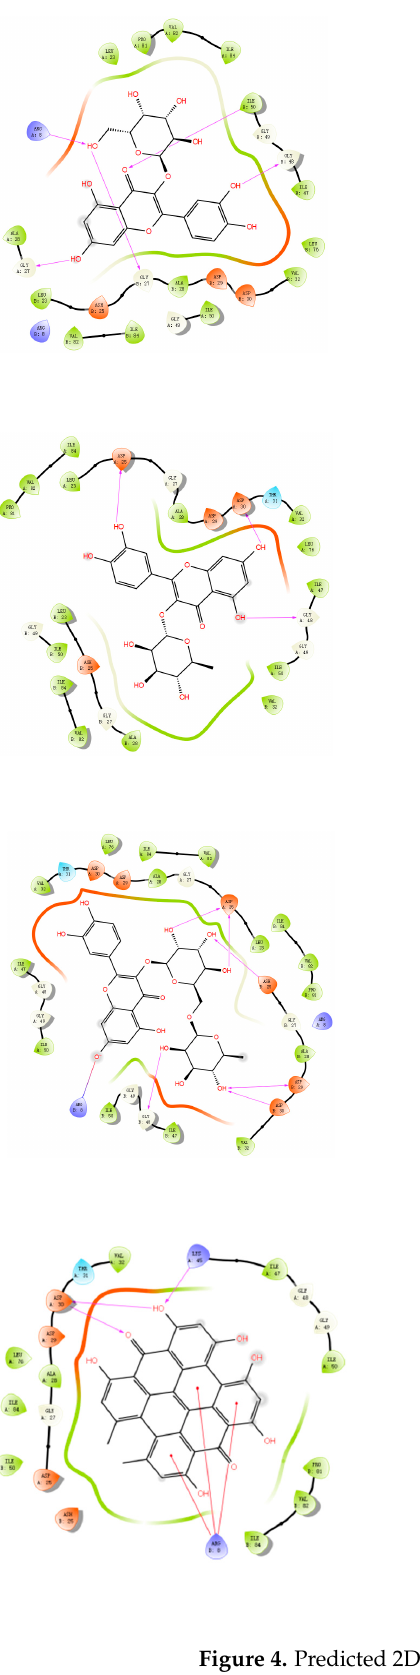
Figure 4. Predicted 2D and 3D binding models of HIV-1 Protease with Hyperoside ( a ), Quercitrin ( b ), Rutin ( c ) and Hypericin ( d ) through molecular docking. Table 7. Docking of the 10 active compounds in the H. kouytchen se insect gall extracts, along with positive control pepstatin A, against HIV ‐ 1 PR.